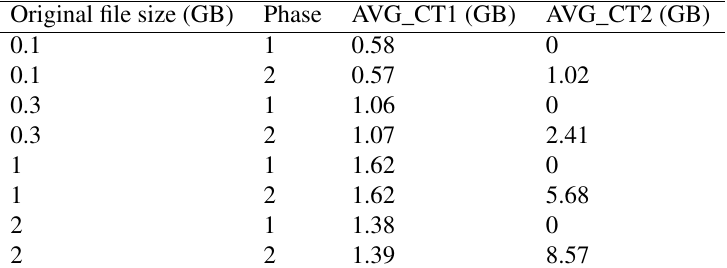
Table 3. Estimated average concurrent tra ffi c within the second experiment.